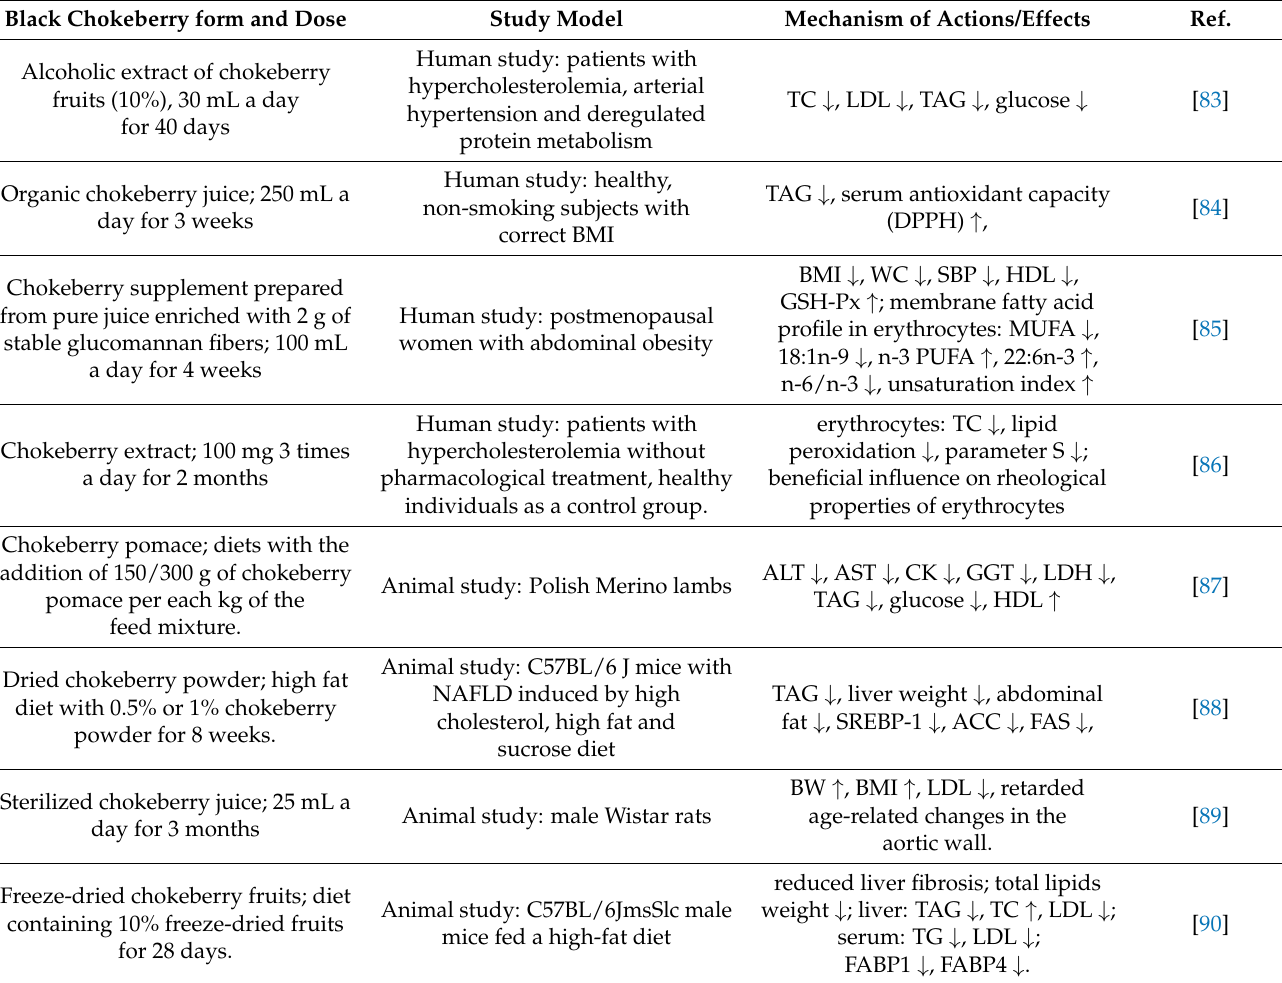
Table 1. Selected human and animal studies concerning effects of black chokeberry on lipid and cholesterol level. Black Chokeberry form and Dose Study Model Mechanism of Actions/Effects